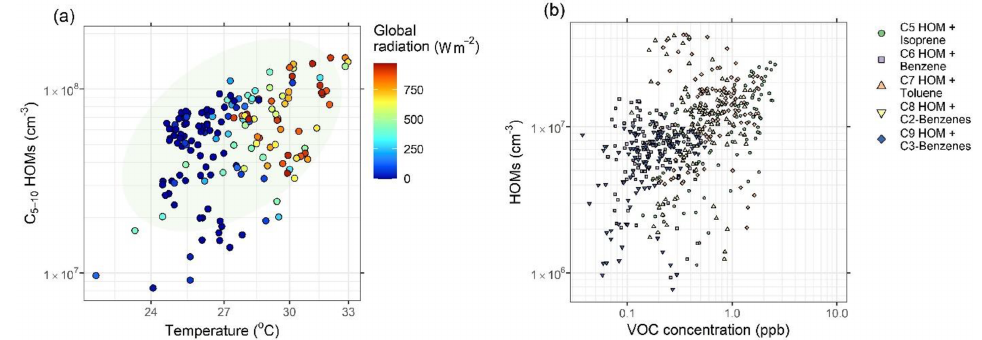
Figure 7. Influencing factors on HOM concentration, showing (a) C 5–10 HOM concentration plotted against temperature, coloured by global radiation. Ellipsis shows 95% confidence on a multivariate t distribution. (b) HOM concentration by carbon number potted against parent VOC mixing ratio. These are segregated by carbon number / VOC, i.e. C 7 HOMs plotted against toluene, under the assumption that toluene oxidation is the main producer of C 7 HOMs. Time resolution for both plots is hourly.